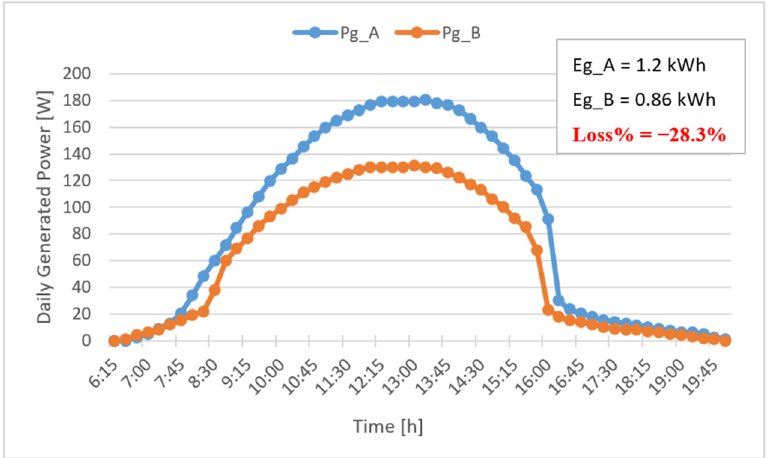
Figure 9. Daily power generation curves, Pg_A and Pg_B, of the two prototypal PV generators A and B on a July 2021 cloudless day, together with corresponding daily generated energy values, Eg_A and Eg_B, and the percentage energy loss factor, Loss%. In this experiment, a shading plywood sheet was mounted only on three PV cells of the homemade submodule of the PV generator B, and the corresponding bypass diode intervened early and remained in the conduction mode until the evening.